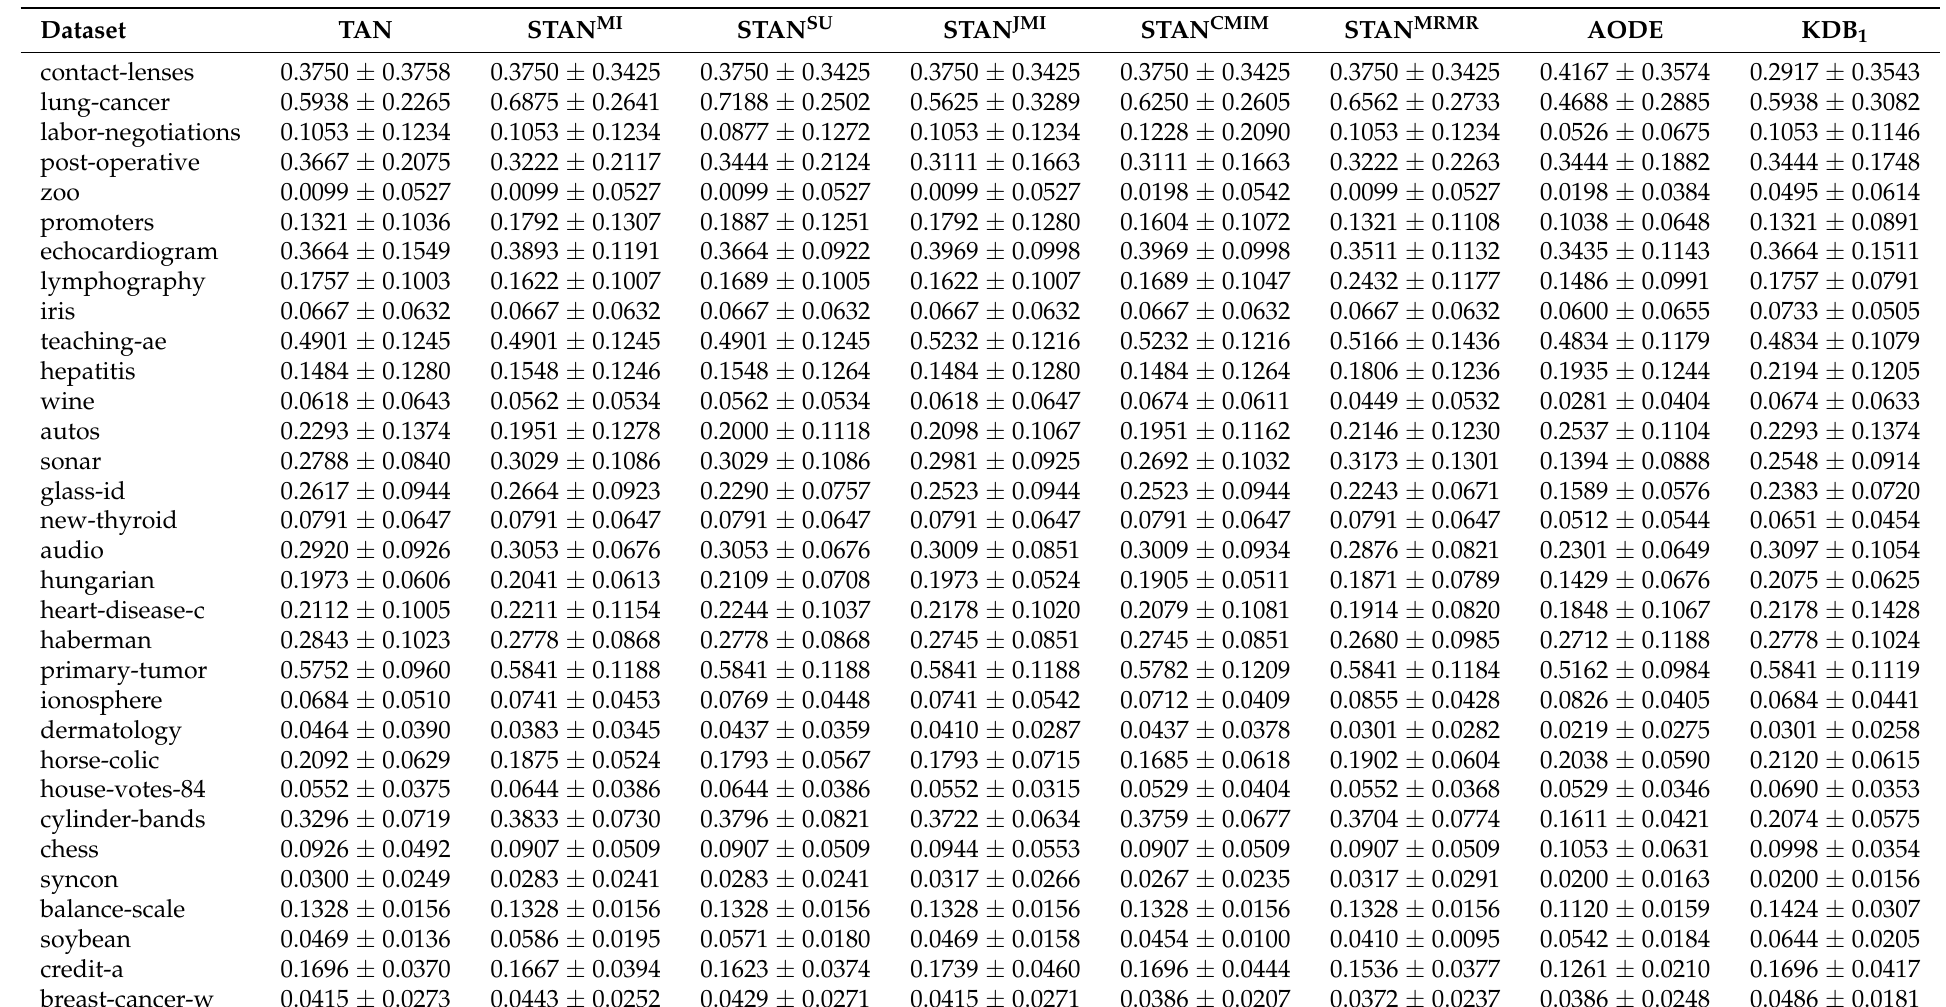
Table A1. ZOL results of 8 algorithms on 70 data